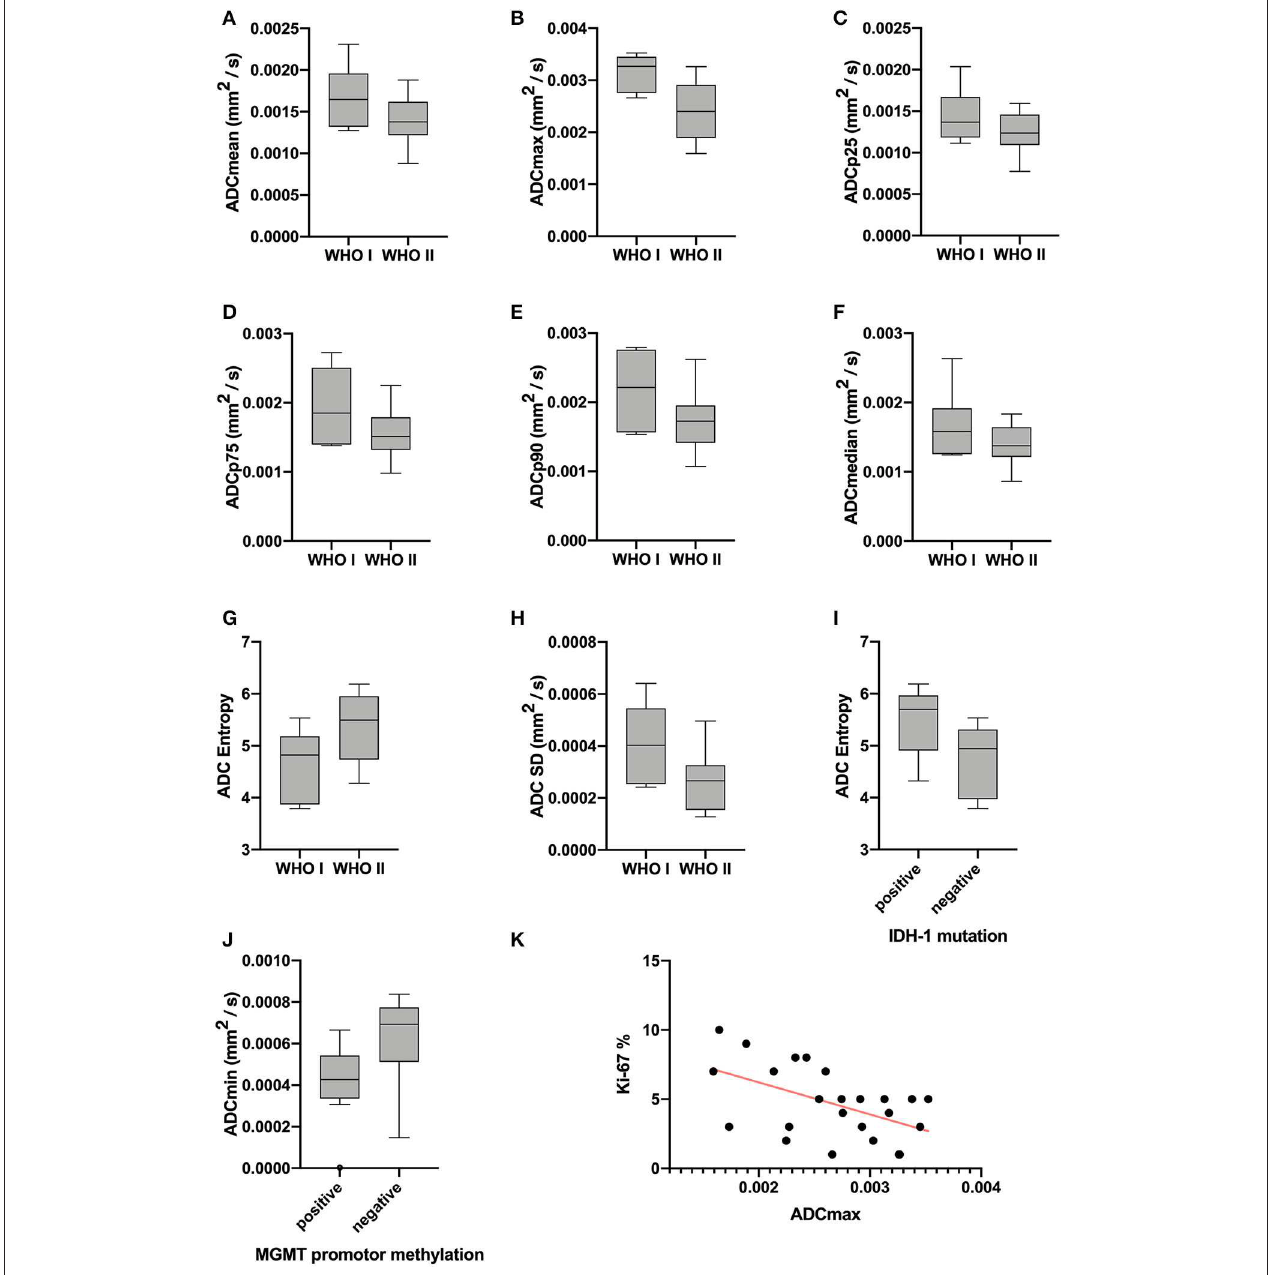
FIGURE 2 | Provides boxplots of statistically significant differences between the diffusion profile of grade I and grade II gliomas (A–H) as well as between IDH-1 mutation status (I) and MGMT promotor methylation status (J) positive and negative tumors. The last image (K) shows the significant correlation between ADCmax of the whole tumor ADC histograms and the proliferation index Ki-67, the set of parameters with the strongest correlation (r = − 0.5218, p =